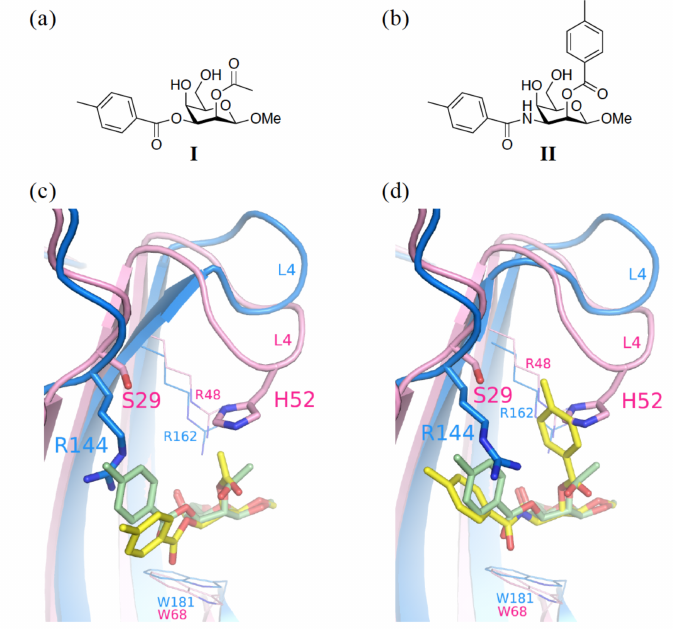
Figure 10. Molecular structures of the two talosides, including ( a ) methyl 2- O -acetyl-3- O -toluoyl- β -D- talopyranoside ( I ) and ( b ) methyl 3-deoxy-2- O -toluoyl-3- N- toluoyl- β -D-talopyranoside ( II ). Despite similar structures of I and II , their affinity with GAL-1 is different ( K d > 4 mM and K d = 2.4 mM, respectively). ( c ) The complex structure of GAL-1 (pink)– I (pale green) is superimposed with that of GAL-3 (marine blue)– I (yellow). ( d ) The complex structure of GAL-1 (pink)– I (pale green) is superimposed with that of GAL-3 (marine blue)– II (yellow).